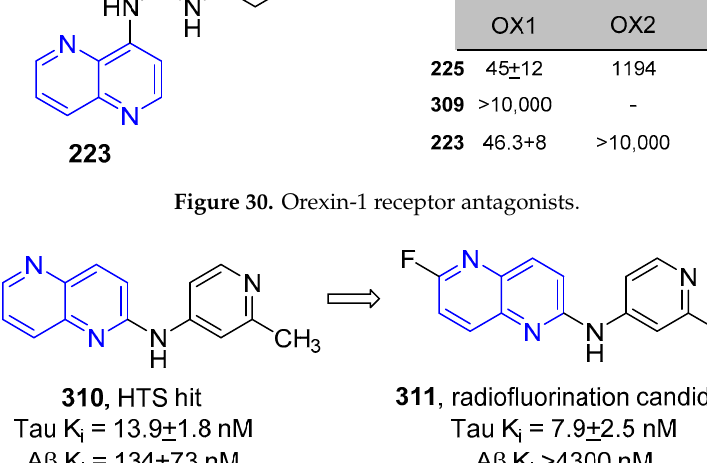
Figure 31. Selective tau aggregate binder.